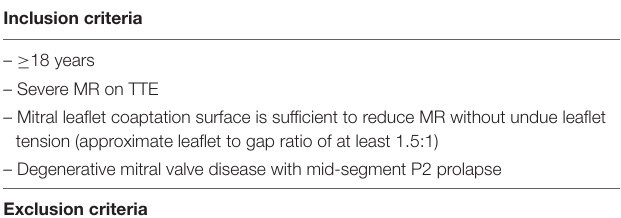
TABLE 2 | Screening criteria for HARPOON BHMVR.